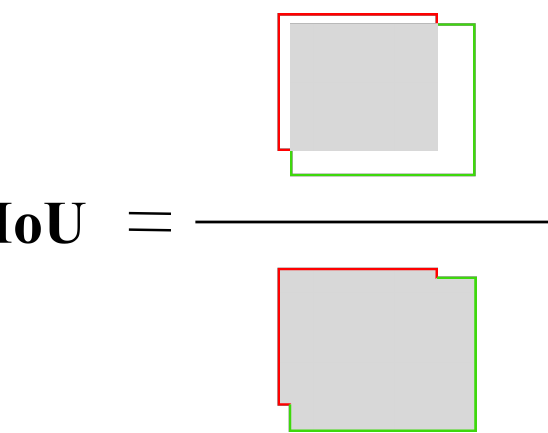
Figure 10. Illustration of the process of IoU calculation.